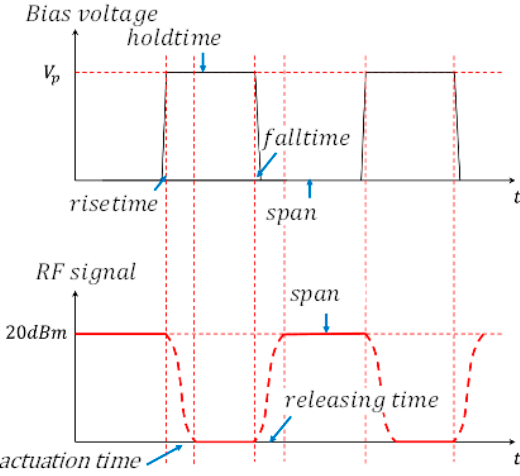
Figure 9. The principle of actuation time and releasing time test.